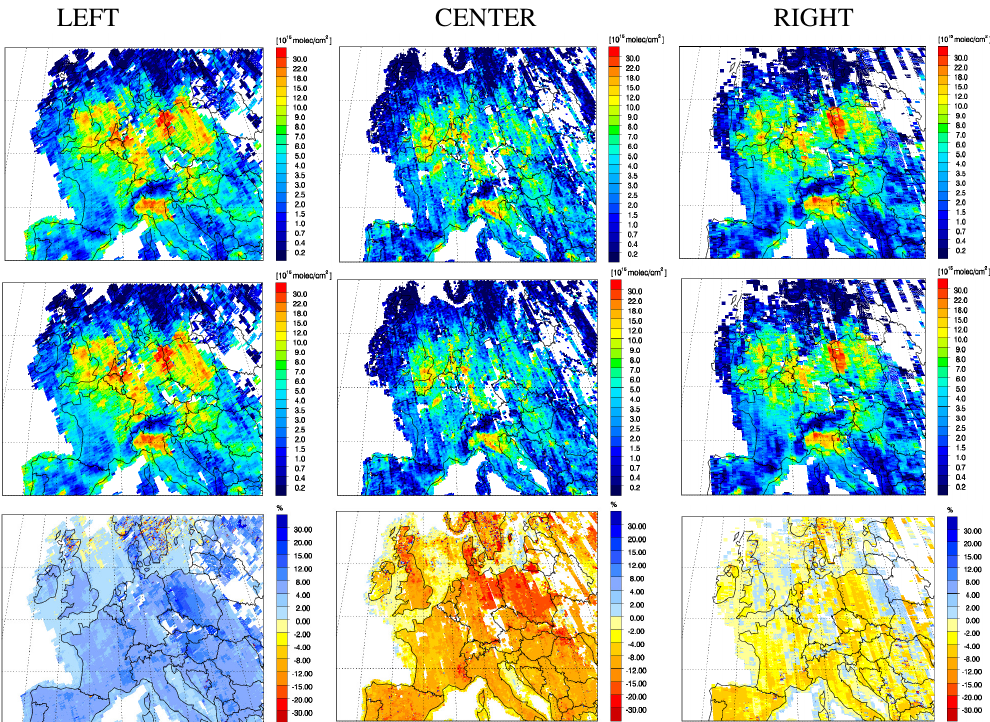
Fig. 13. Binning of mean NO 2 VTCs in November averaged over 2006 and 2007 retrieved with full BRDF surface treatment (first row) and black-sky albedo (second row), and mean relative differences of NO bs (third row) in regard to the location of pixels in OMI swaths. Results in the left panels are from pixels located at the 3rd to 10th left-most positions in the swath, those in the middle panels from pixels at the eight center positions, and those in the right panels from the pixels located at the 3rd to 10th right-most positions in the swath.